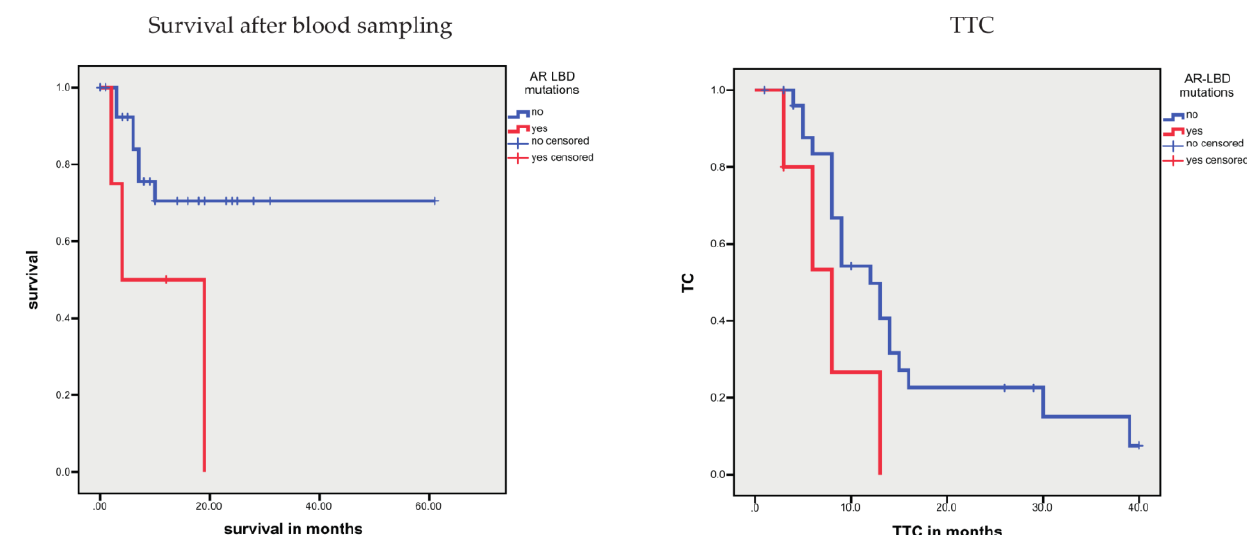
Figure 5. Kaplan–Meier analysis: AR-LBD mutations are associated with survival after blood sampling and TTC. Patients with AR-LBD mutations showed a shorter survival after blood sampling ( p = 0.036) and, as a trend, a shorter TTC ( p = 0.050).